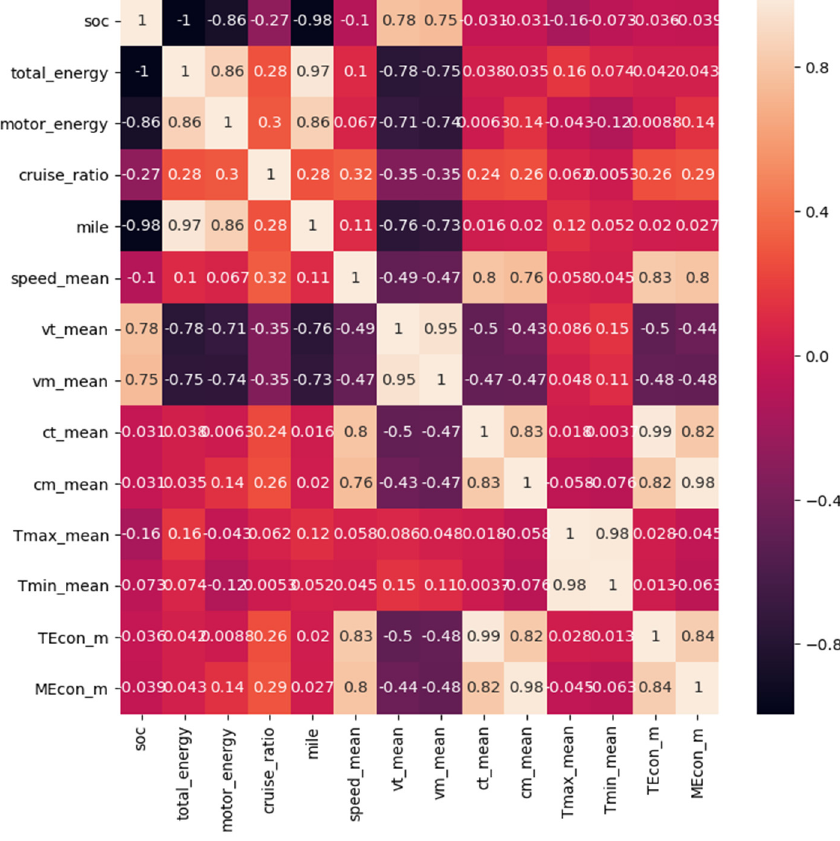
Figure 2. The correlation of the original features.